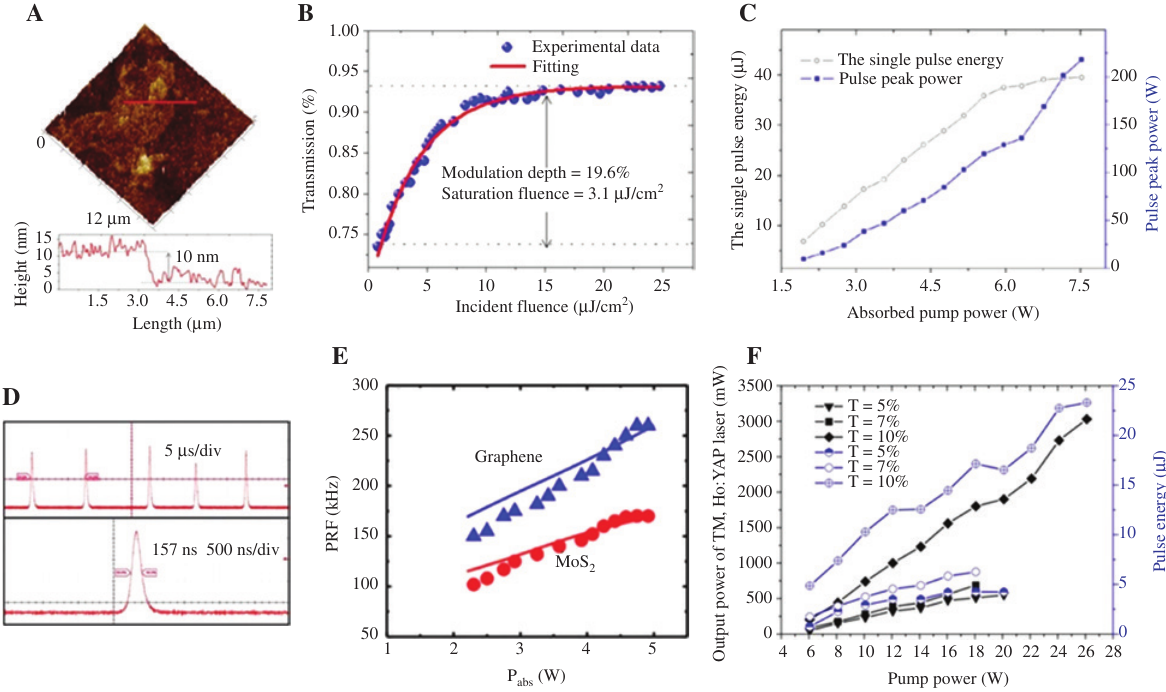
Q-switched mid-infrared lasers. Figure 17: Performance of BP, graphene, and MoS 2 (A) AFM image and typical height profile and (B) saturable absorption behavior of BP SA mirror. (C) The single pulse energy and peak power vs. absorbed pump power of the BP Q-switched laser. Reproduced with permission [310]. Copyright 2014, Optical Society of America. (D) The typical pulse trains of graphene Q-switched Cr:ZnSe laser with the minimum pulse width of 157 ns. Reproduced with permission [277]. Copyright 2015, IEEE Photonics Society. (E) Pulse repetition frequency of graphene and MoS Q-switched Tm:KLuW lasers. Reproduced with 2 permission [228]. Copyright 2016, Optical Society of America. (F) Average output powers of the layered MoS Q-switched Tm,Ho:YAP lasers. 2 Reproduced with permission [285]. Copyright 2018, Optical Society of